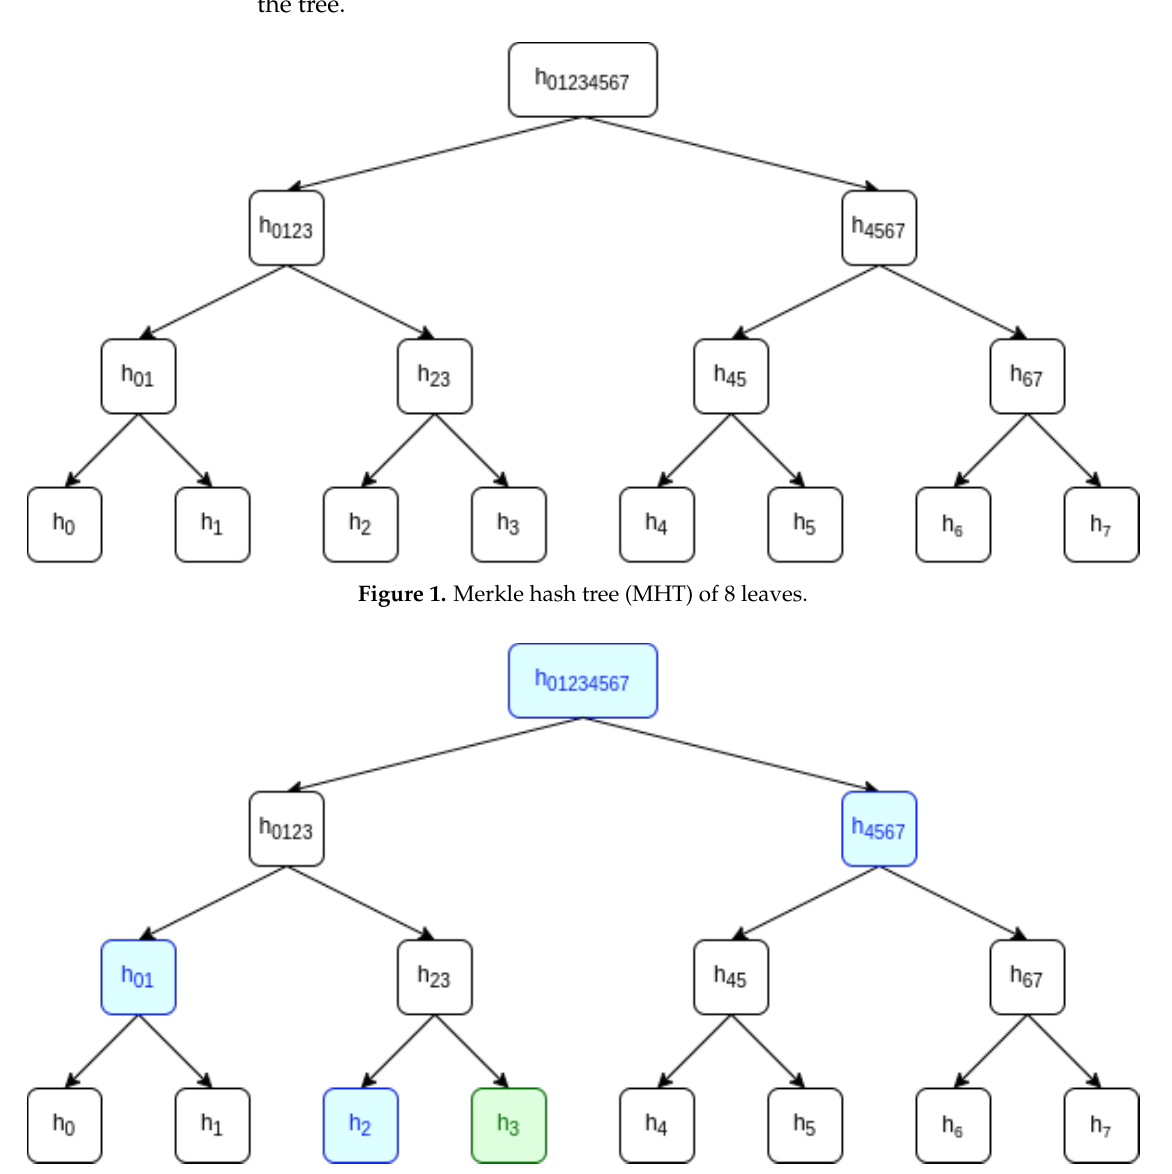
Figure 2. The Merkle proof (MP) of h 3 is the set { h 01234567 , h 4567 , h 01 , h 2 } , which contains the nodes needed to compute the MR of the